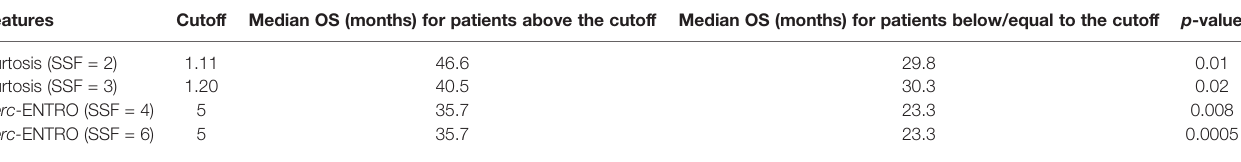
TABLE 3 | Kaplan – Meier analysis for signi fi cant texture predictors of OS.